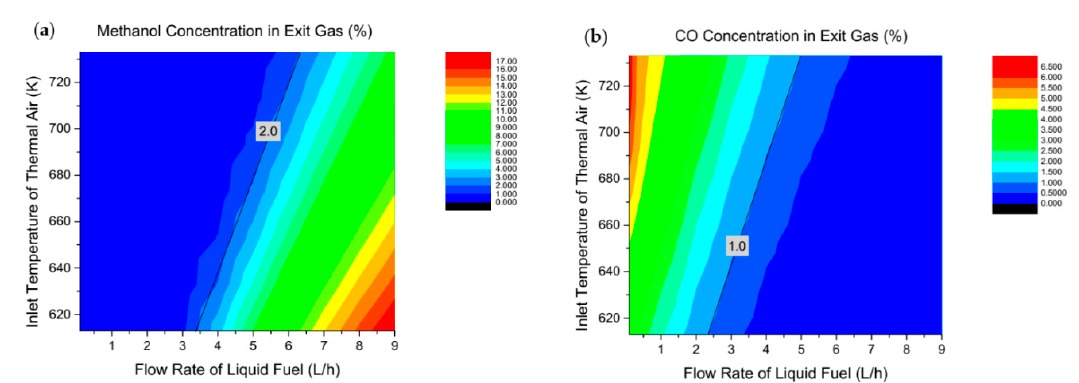
Figure 15. Profiles of the ( a ) methanol concentration and ( b ) CO concentration in the exit gas of the reformer with different inlet flow rates for the fuel mixture and inlet temperature of the thermal air